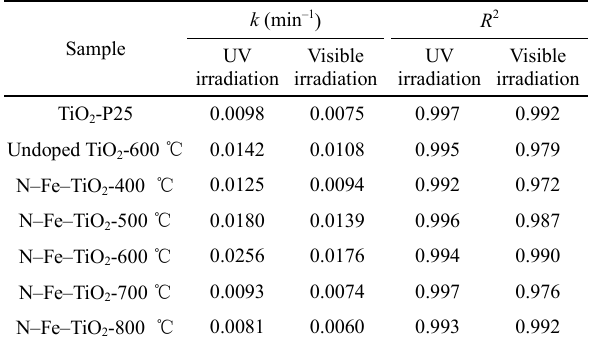
Fig. 8 First-order kinetics plots for the photocatalytic degradation of RhB without catalyst material and in presence of reference P25, undoped TiO 2 nanorod, and N–Fe codoped TiO 2 nanorods annealed at different temperatures under (a) UV light irradiation and (b) visible-light irradiation. Table 2 Values of apparent rate constant k and R 2 for the different